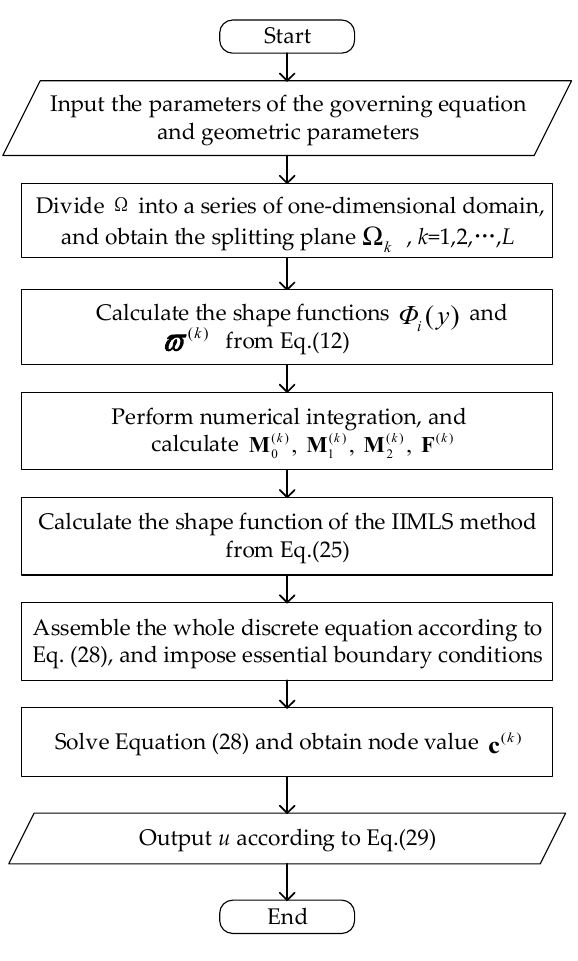
Figure 1. A flow chart for obtaining the numerical solutions of the DS-GIEFG method.